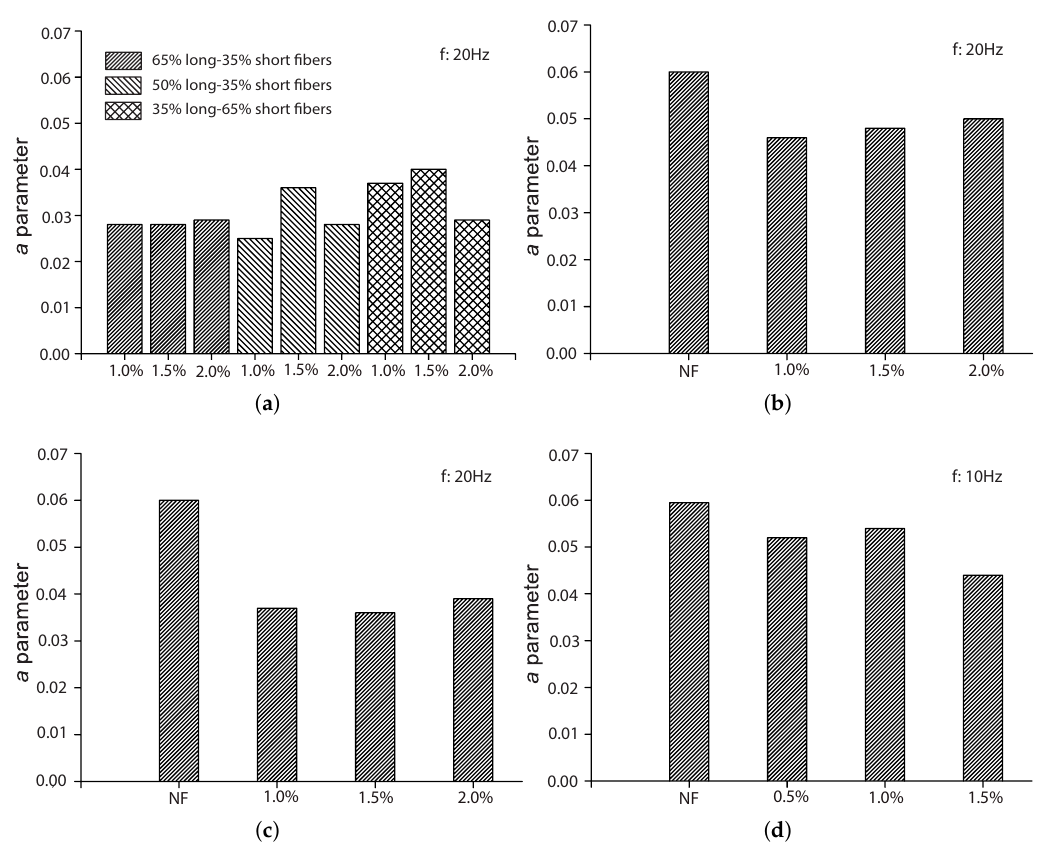
Figure 12. Influence of fiber volume fraction on parameter a : ( a ) Singh et al. [42]; ( b ) Mohammadi and Kaushik [17], 50 mm fiber length; ( c ) Mohammadi and Kaushik [17], 25 mm fiber length; ( d ) Goel and Singh [44].